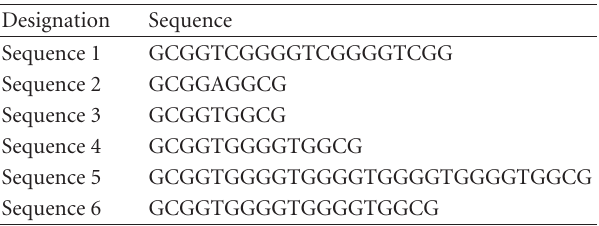
Table 1: The investigated G-rich DNA